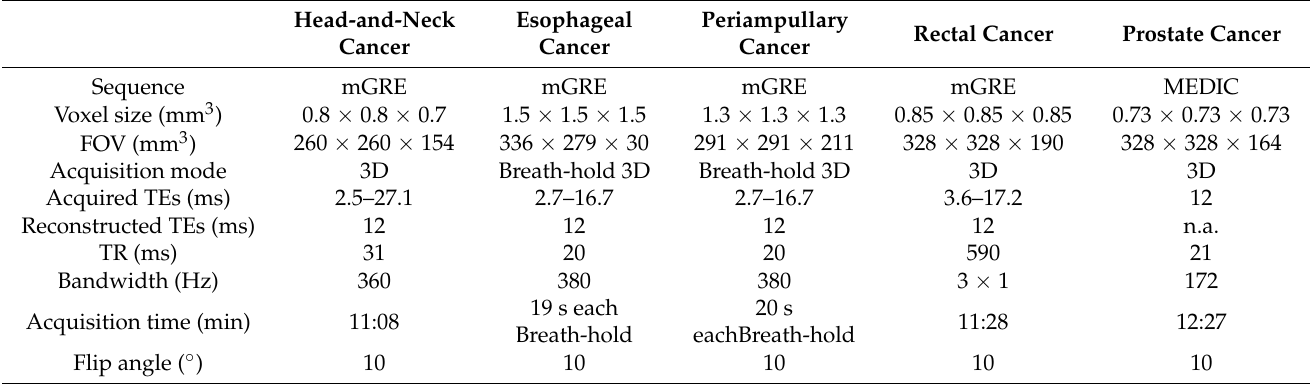
Table 3. Overview of parameters regarding the in vivo T2*-weighted iron-sensitive MR sequences.